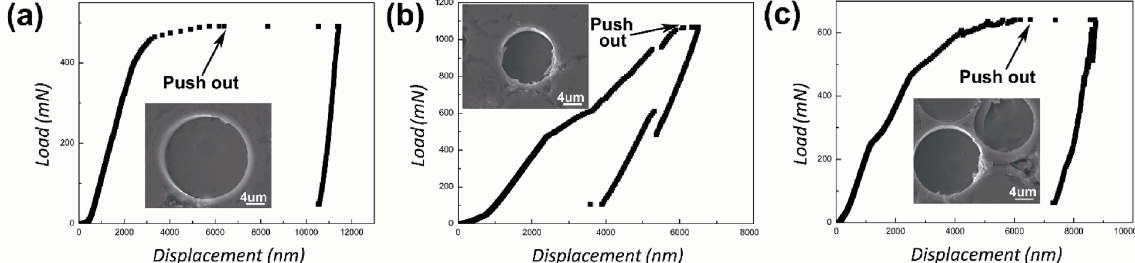
Fig. 4 Representative indentation load vs. displacement curves along with SEM images of pushed fibers of (a) virgin SiC f /SiC composites, (b) as-grown, and (c) BN-coated BNNTs reinforced SiC f /SiC hierarchical composites under single fiber push-out test. BN interphase was deposited for 20